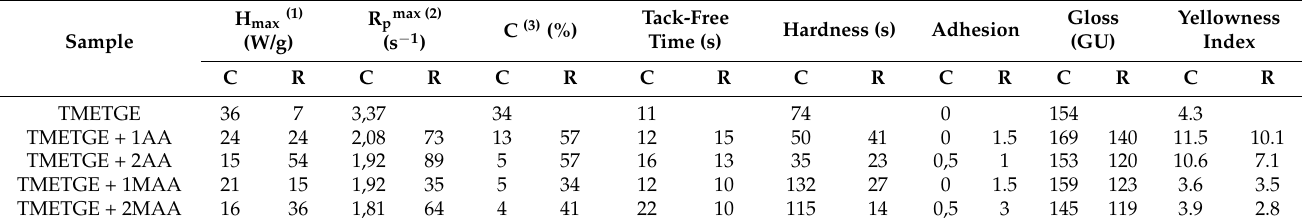
Table 2. The basic properties of the cured coatings depending on the photopolymerization (C—cationic, R—radical).